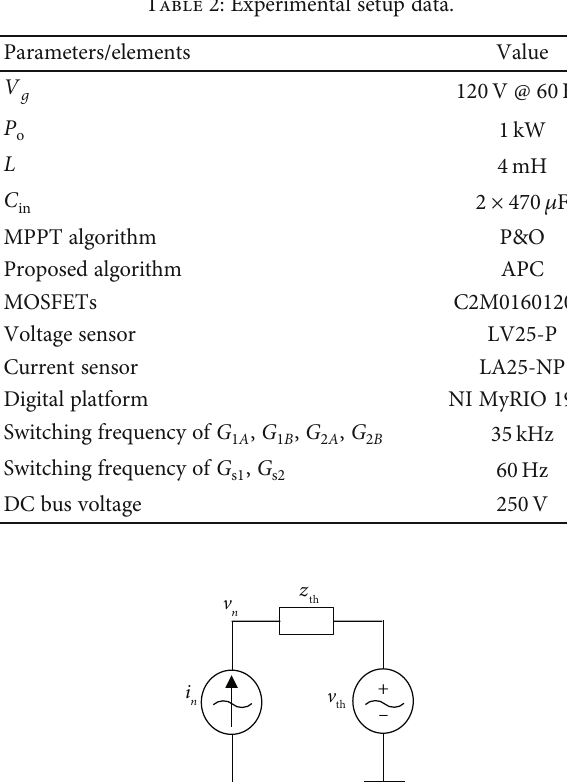
Table 2: Experimental setup data.